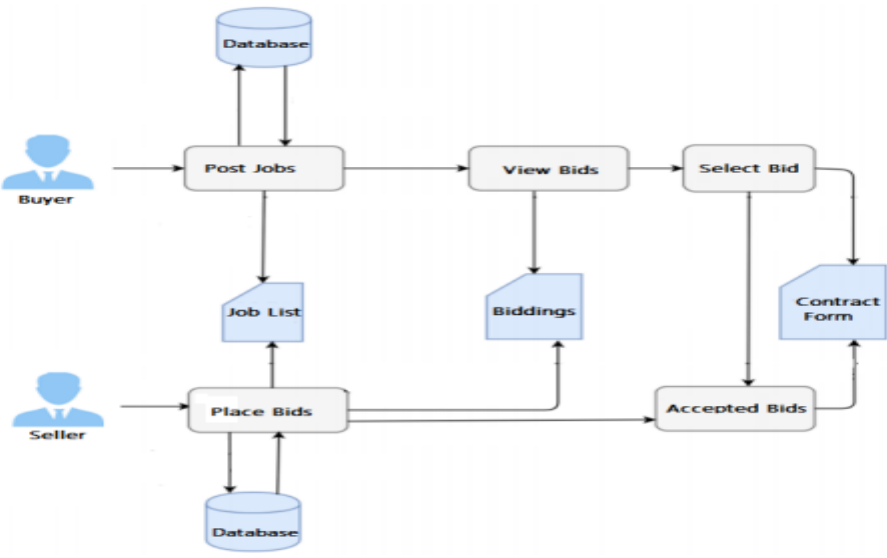
Figure 8. Job posting and bid placing on jobs in the system.